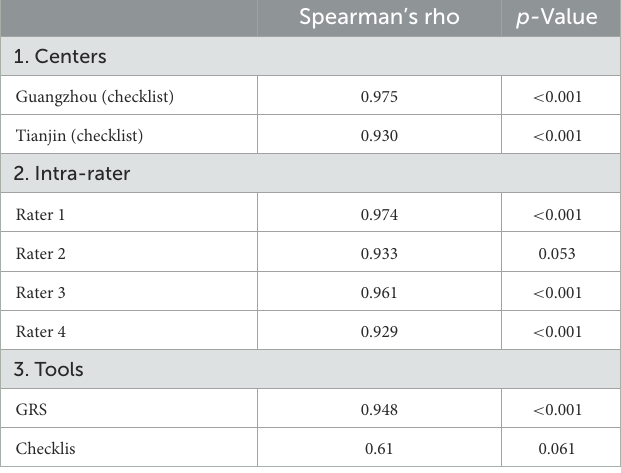
TABLE 5 Reliability for the mean score on different centers, intra-rater, and different tools for the same examinee inter-hospitals.